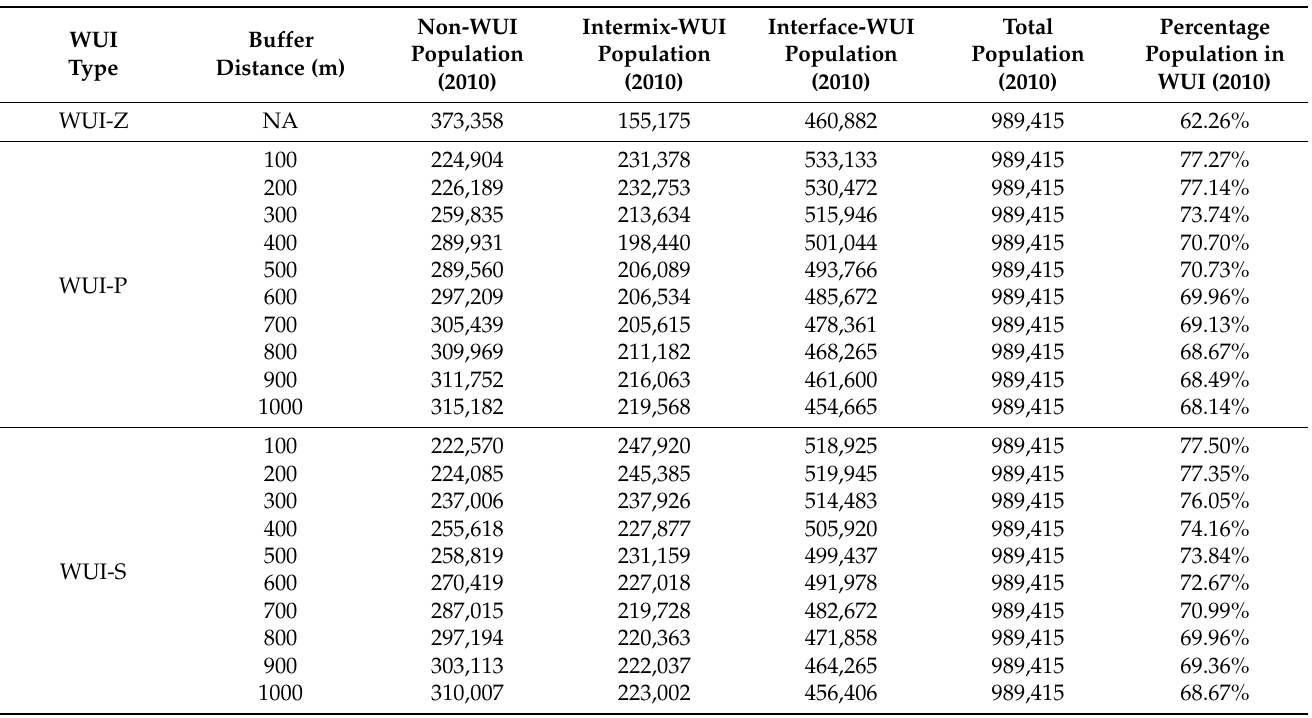
Table 4. The estimated population within the